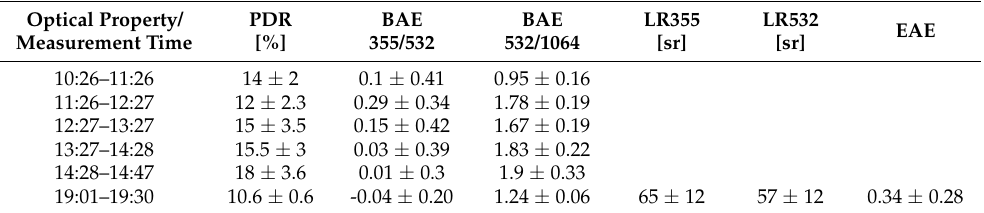
Figure 14. Lidar measurements around 19:15 UTC: particle backscatter coefficient for 355, 532, and 1064 nm ( left ); particle extinction coefficient for 355 and 532 nm ( middle ); and particle linear depolarization ratio at 532 nm ( right ). Table 2. Mean optical properties and their standard deviation retrieved from lidar measurements over 3000–4000 m (2500–3500 m for the night measurement).